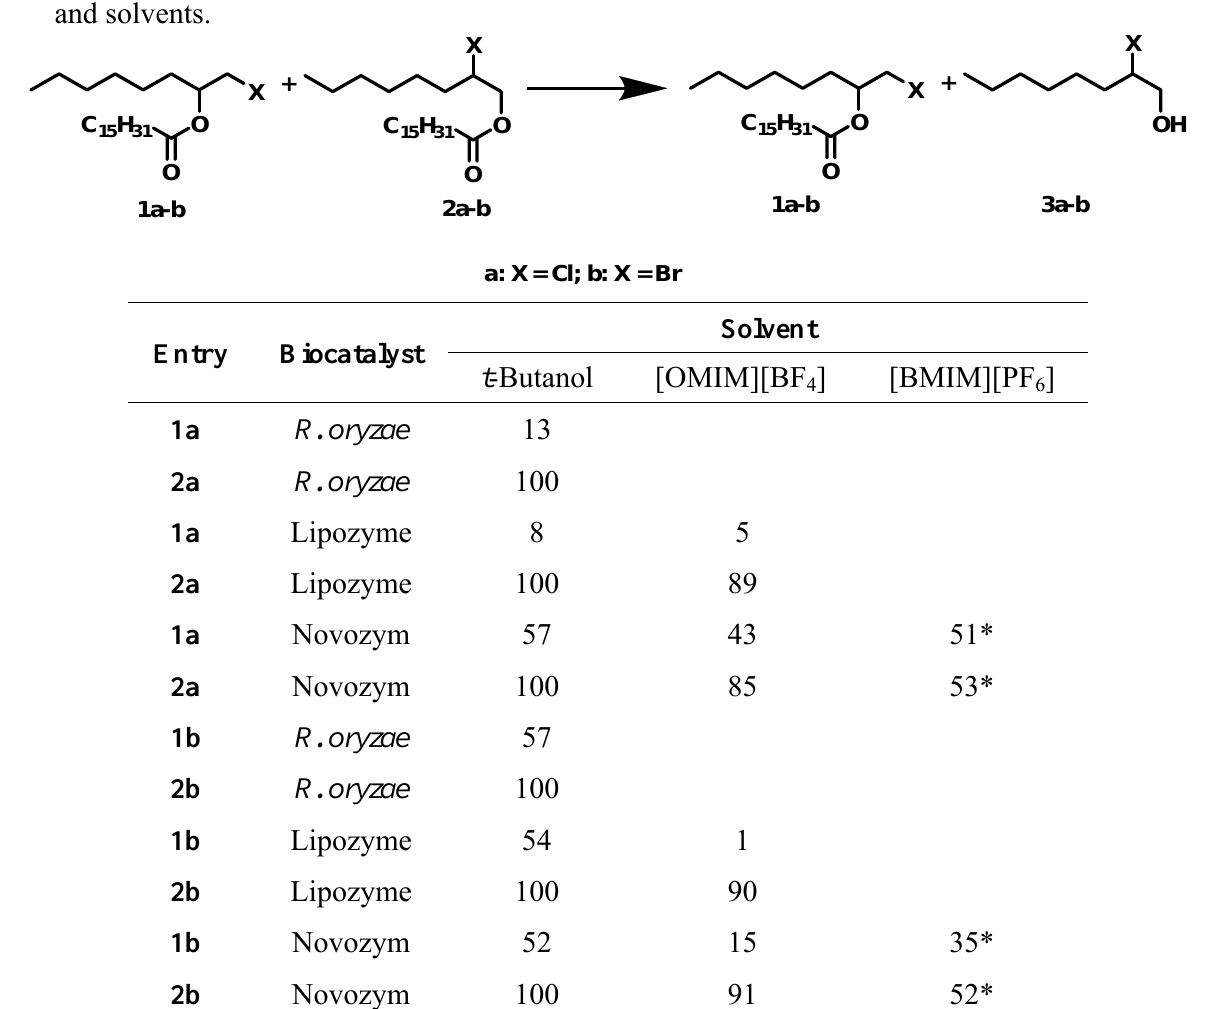
Table 1. Percentage of hydrolysis of both palmitate regioisomers using various biocatalysts and